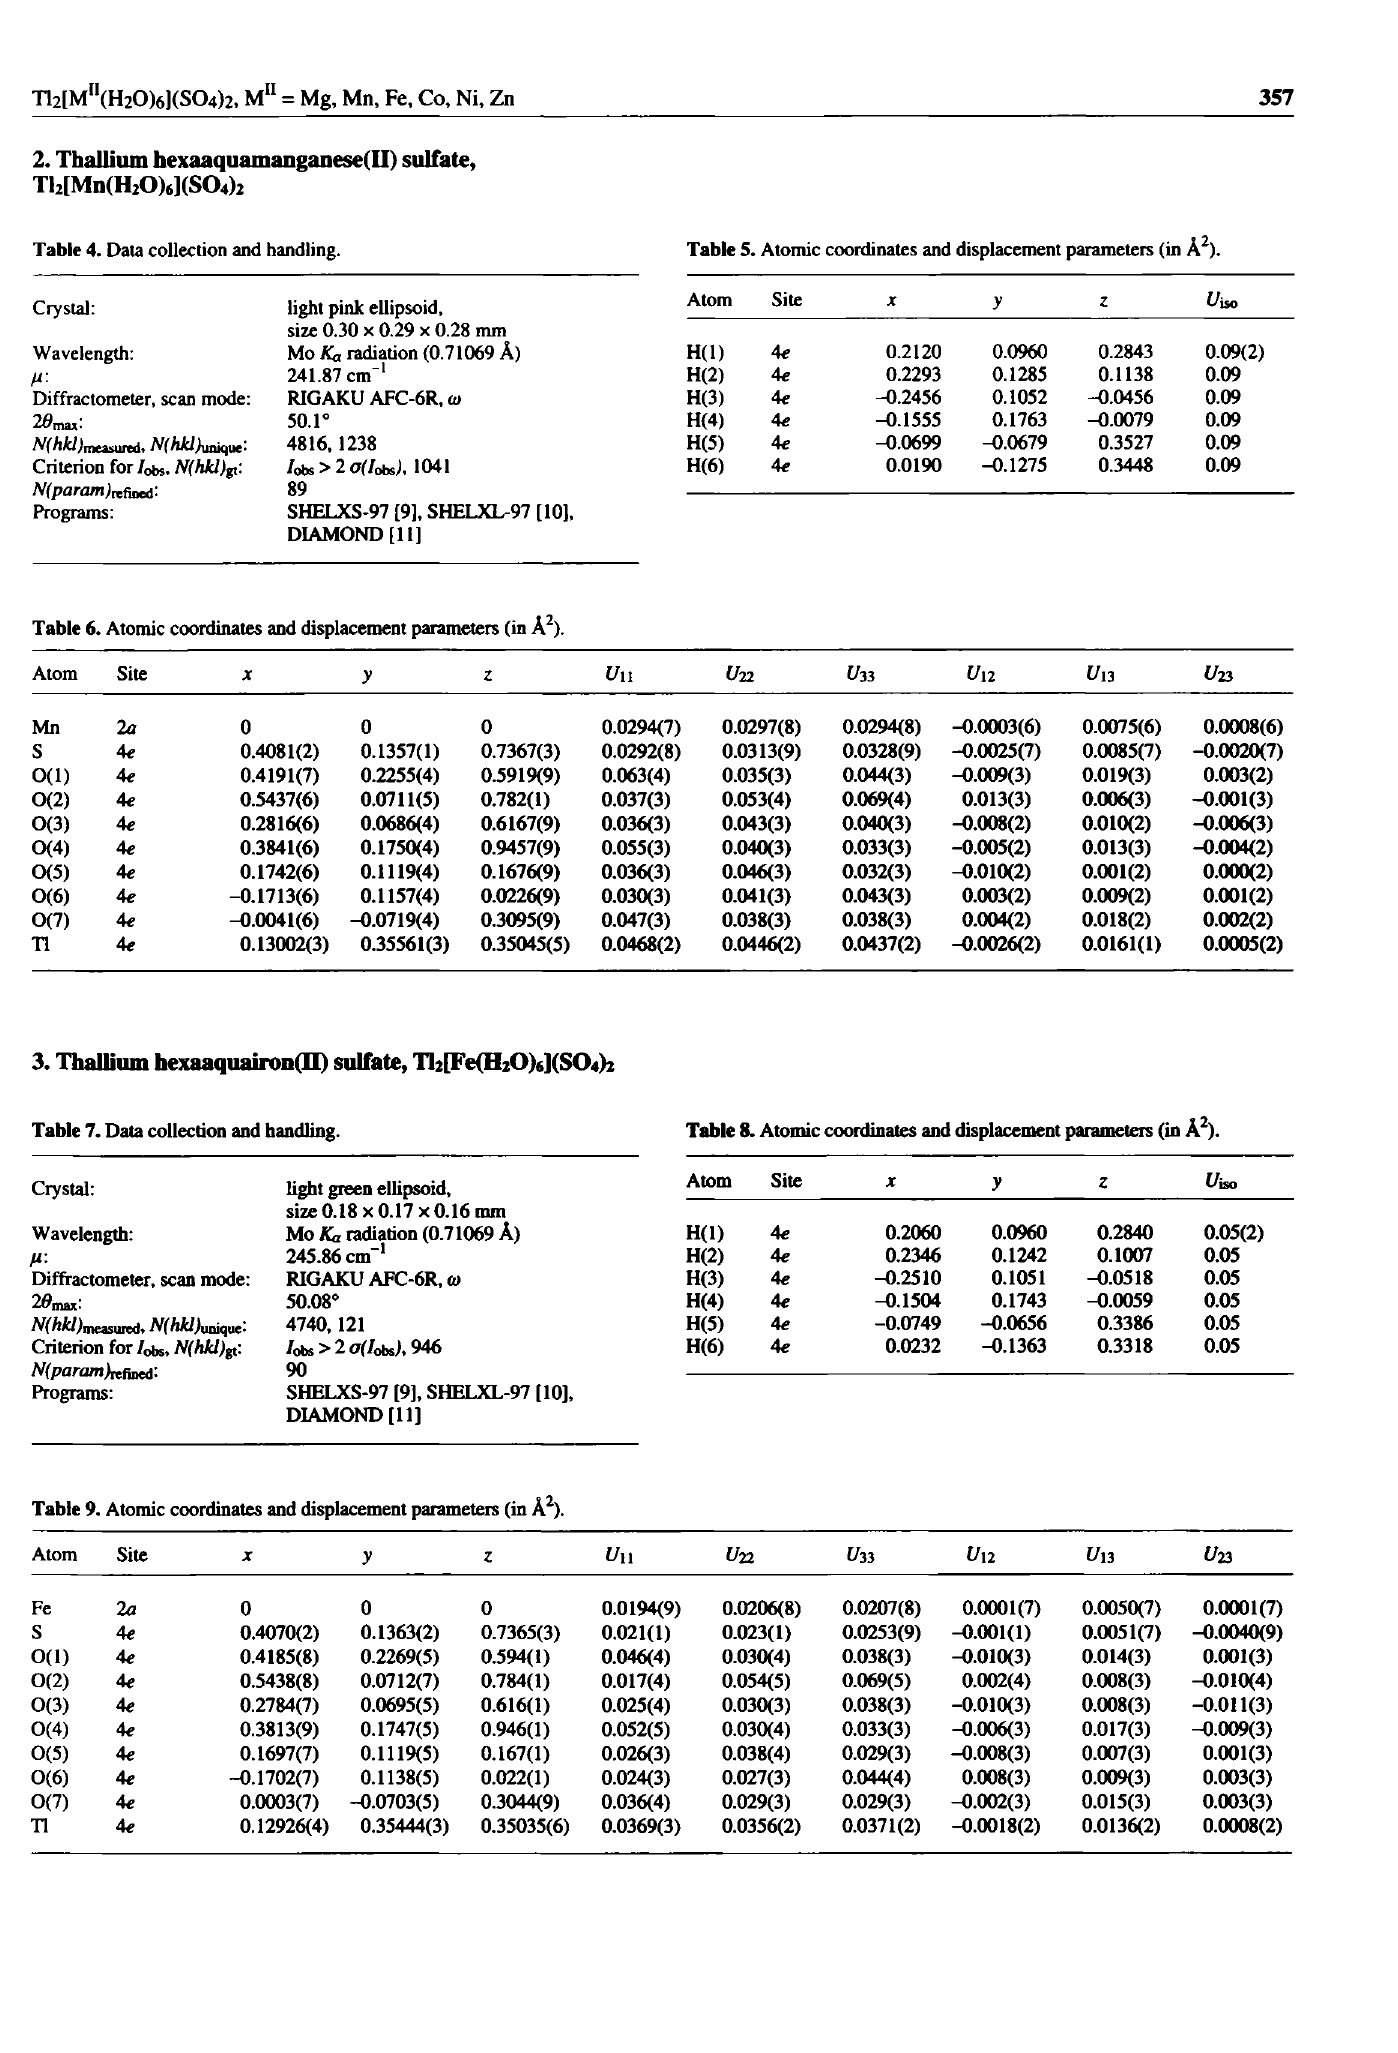
Table 4. Data collection and handling. Table 5. Atomic coordinates and displacement parameters (in À 2 ).